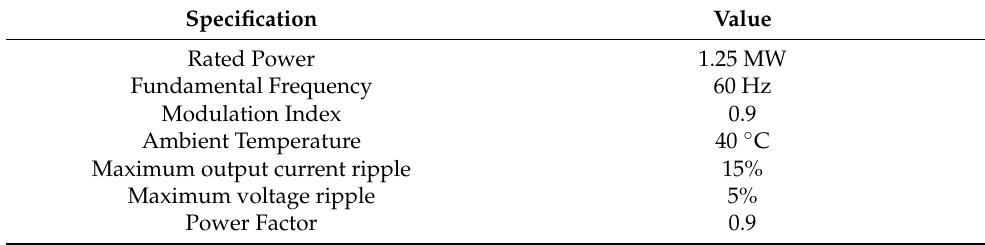
Table 1. Converter specifications and